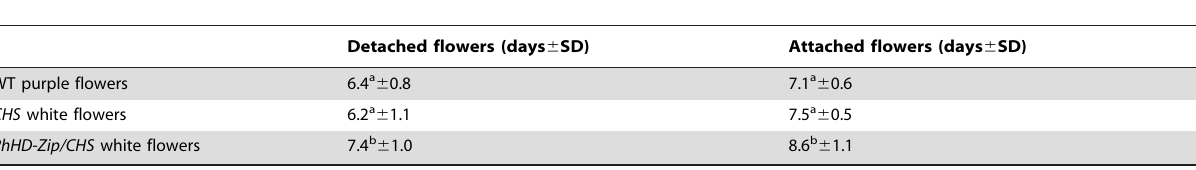
Table 2. Effect of drought on longevity of WT, CHS silenced control and the PhHD-Zip silenced petunia flowers.